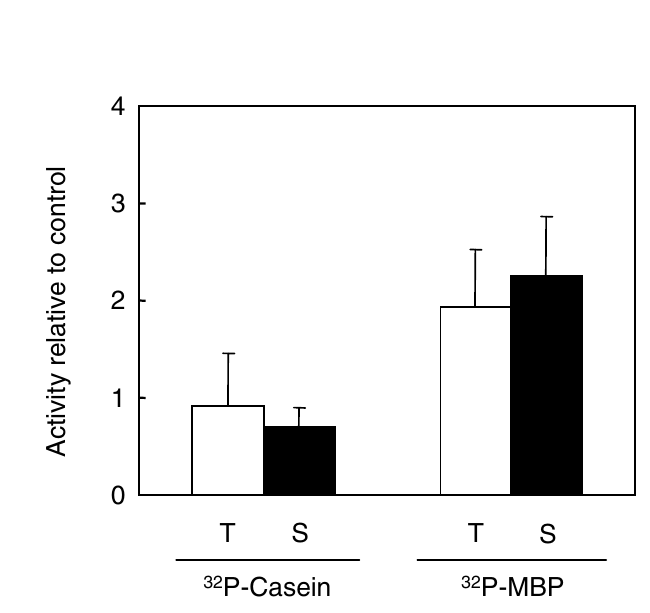
Limited proteolysis of Ppt1p and its effect on Ppt1p activity . (A) Recombinant Ppt1p samples trypsinized in the absence or presence of 250 µ M AA were resolved by electrophoresis on 15% SDS-polyacrylamide gel and visualized by Coomassie staining. The length of digest (minutes) and the migration of molecular weight standards are indicated. (B) N-termi- nal sequence analysis of 45 kDa fragments shown in (A) was performed to identify the tryptic cleavage sites within the linker region between the TPR and catalytic domains. Tryptic cleavage sites are indicated with the inverted triangles. Bold underlined residues are conserved in both Ppt1p and PP5. (C) Recombinant Ppt1p was digested using either trypsin (T) or subtilisin (S) for 5 minutes in the absence of AA and assayed using either 32 P-casein or 32 P-MBP in the absence of AA. Data are presented as activity relative to control, which is the activity of full-length Ppt1p subjected to mock digest and assayed in the absence of AA. Results represent the mean ± S.E. from three or more independent